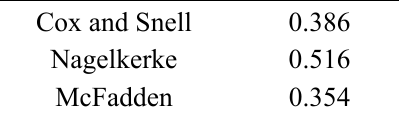
Table A3. Pseudo R-Square.